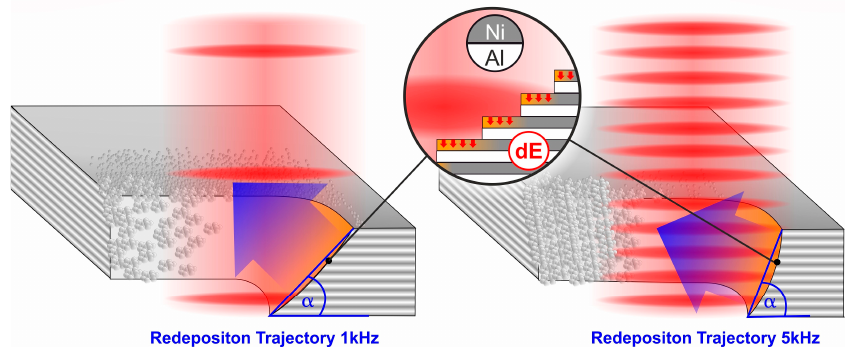
Figure 7. Change in the trajectory of redeposited debris and oxide due to cutting inclination for the di ff erent repetition rates used; 1 kHz on the left side and 5 kHz on the right side.